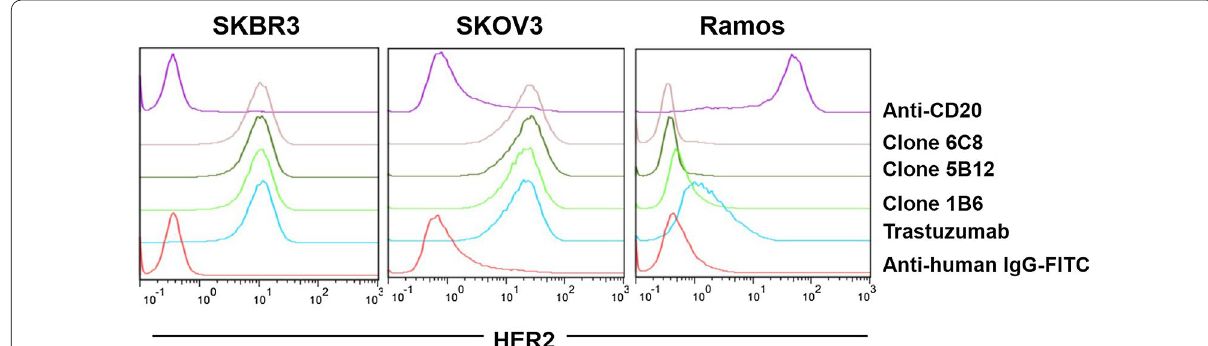
Fig. 10 Recognition of HER2‑expressing tumor cell lines. SKOV3, SKBR3 and Ramos cell lines were stained with 10 μg/mL of produced antibody contained in cell culture supernatants of 1B6, 6C8 and 5B12 clones, followed by a FITC‑labeled rabbit anti‑human IgG antibody. Commercial trastuzumab was used as positive control and cell culture supernatant of anti‑CD20 expressing clone, as isotype matched control. Ramos cells (CD20 ) were used as control of non‑HER2 expressing cells. Results are representative of two independent +